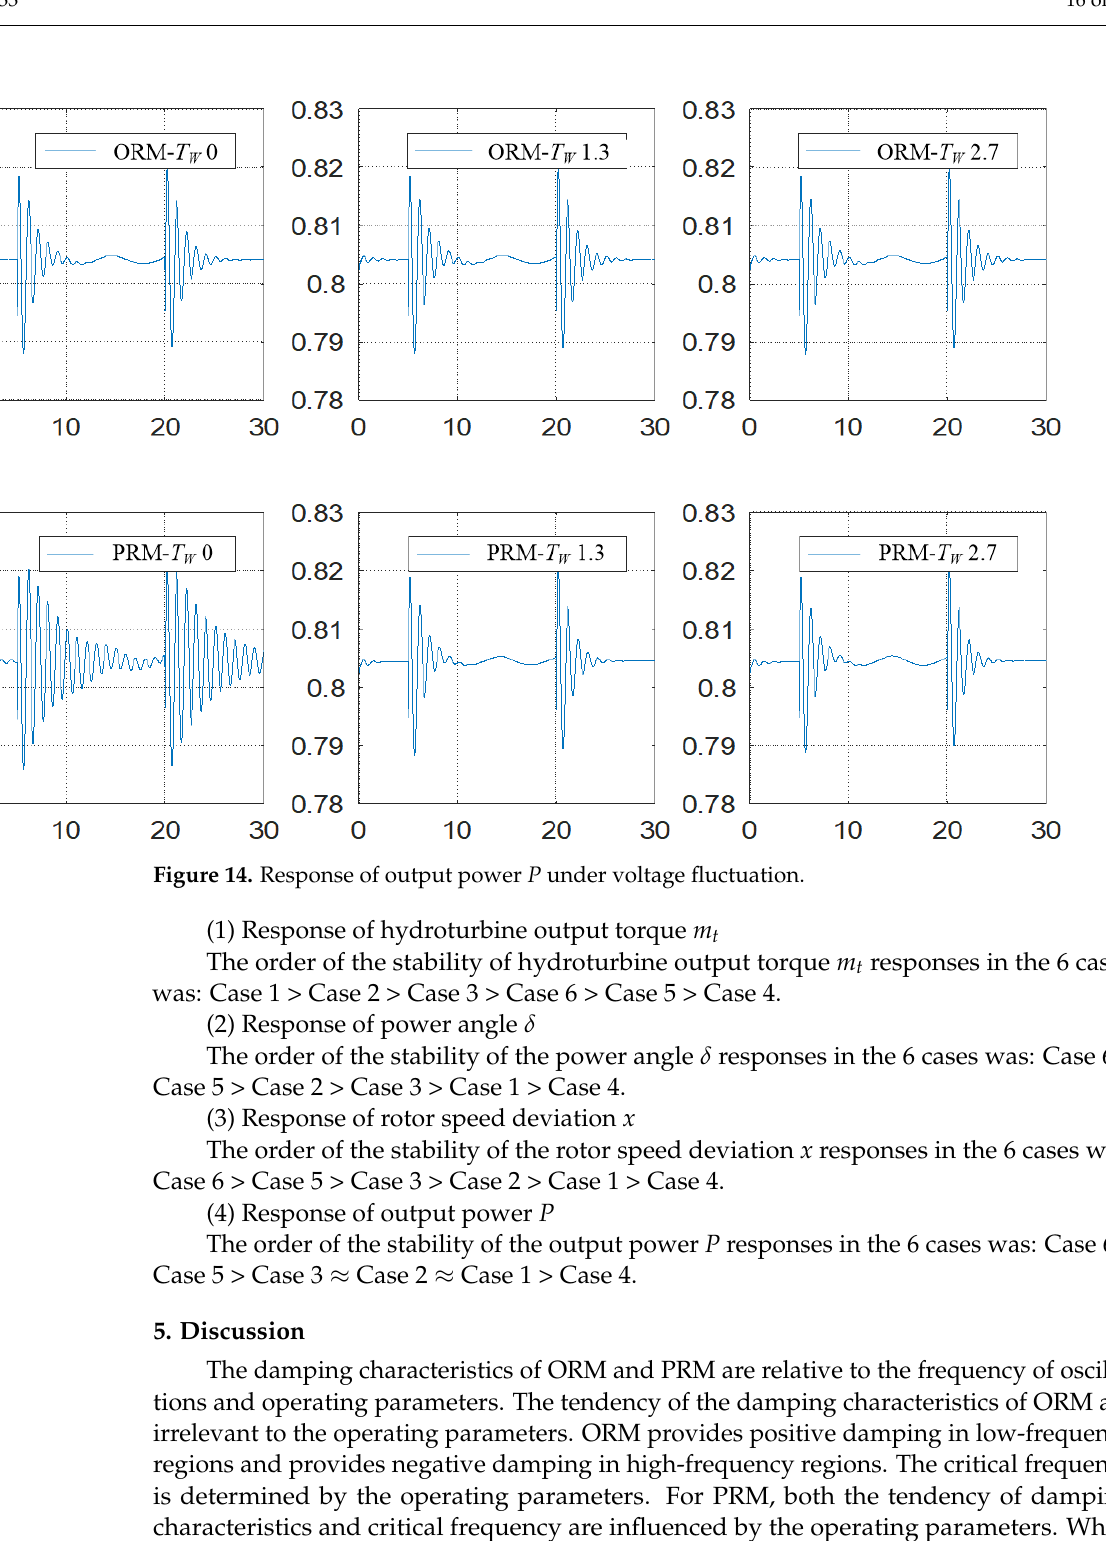
Figure 13. Response of rotor speed deviation x under voltage fluctuation.